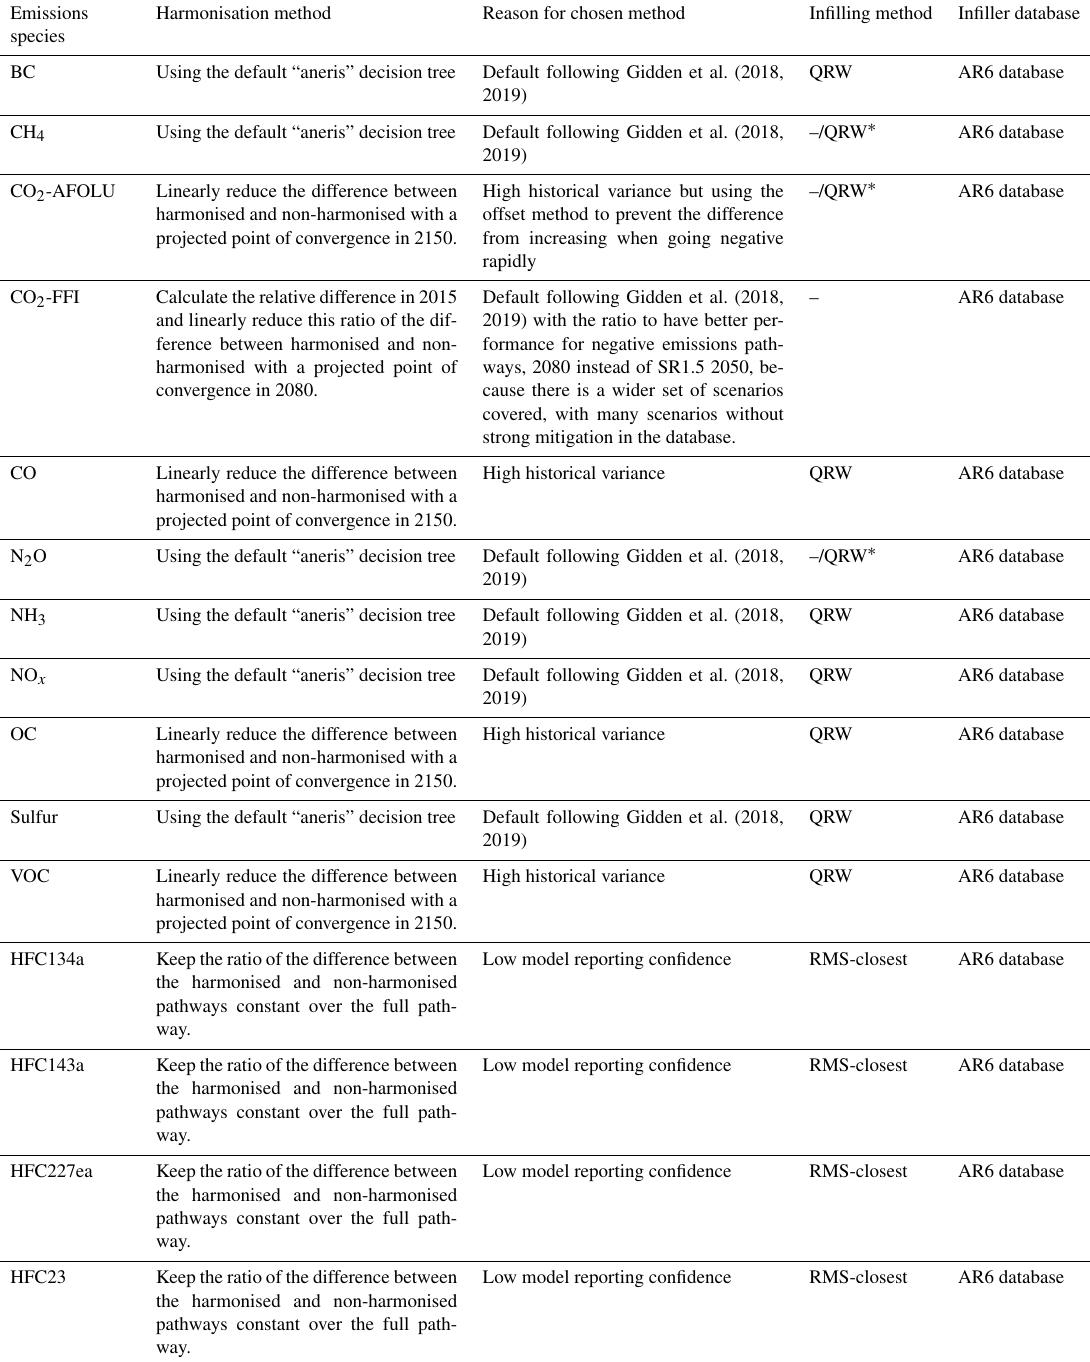
Table 1. Harmonisation and infilling methods by emissions species as applied in AR6 WGIII. An asterisk ( ∗ ) means that the methods are in place but not used in the report because these emissions species were available for all 1202 assessed scenarios such that infilling was not necessary. The historical emissions database used for harmonisation was in all cases the database also used for RCMIP (Nicholls et al., 2021). Gidden et al. refers to Gidden et al. (2018, 2019). The reasons for varying the infilling method and database are explained in the text of this paper and are purely dependent on the availability of the number of modelled pathways and their independence in each database. QRW is used when a sufficient number of independent pathways is available in the AR6 infiller database (Kikstra et al., 2022b); otherwise, RMS-closest is chosen. CMIP6-SSPs is chosen as the database if the gas in question is not represented in the AR6